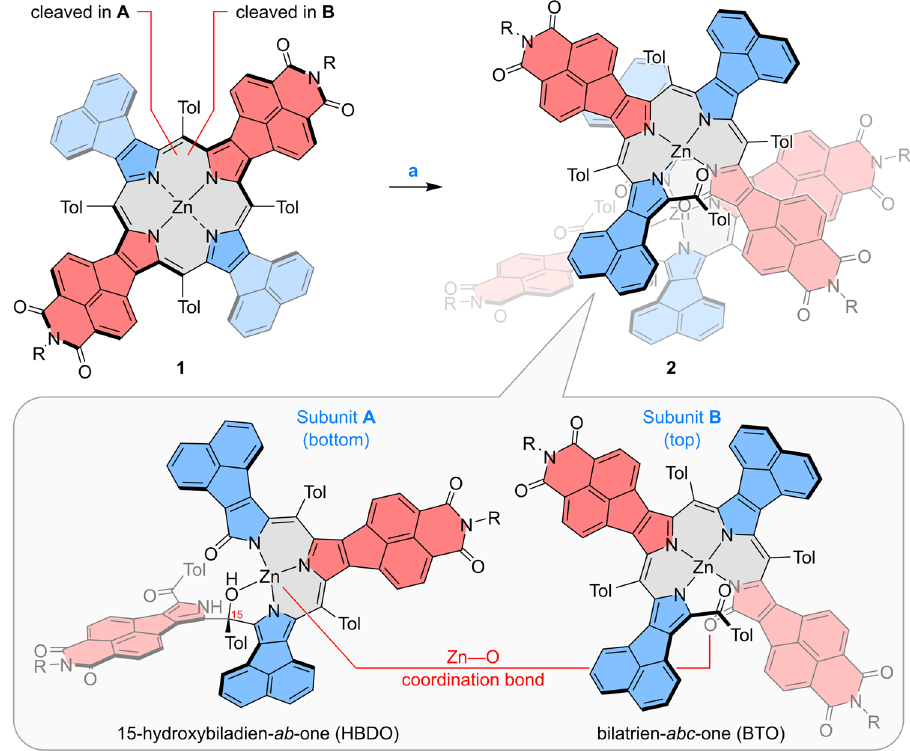
Fig. 2 Single-step conversion of 1 into heterodimer 2. Reagents and conditions: (a) toluene in air, visible light irradiation. Acceptor and donor pyrrole subunits are highlighted in red and blue, respectively. R =